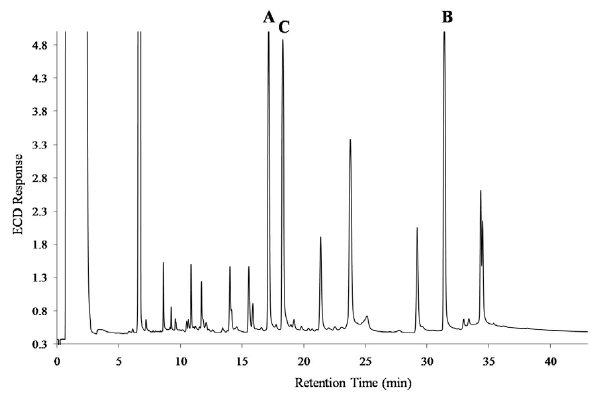
Figure 5. GC-ECD chromatogram of the synthesized INs. The peaks labeled A-C correspond to the INs with the same label in Figure 3. Fig. 5. GC-ECD chromatogram of the synthesized INs. The peaks labeled A–C correspond to the INs with the same label in Fig.